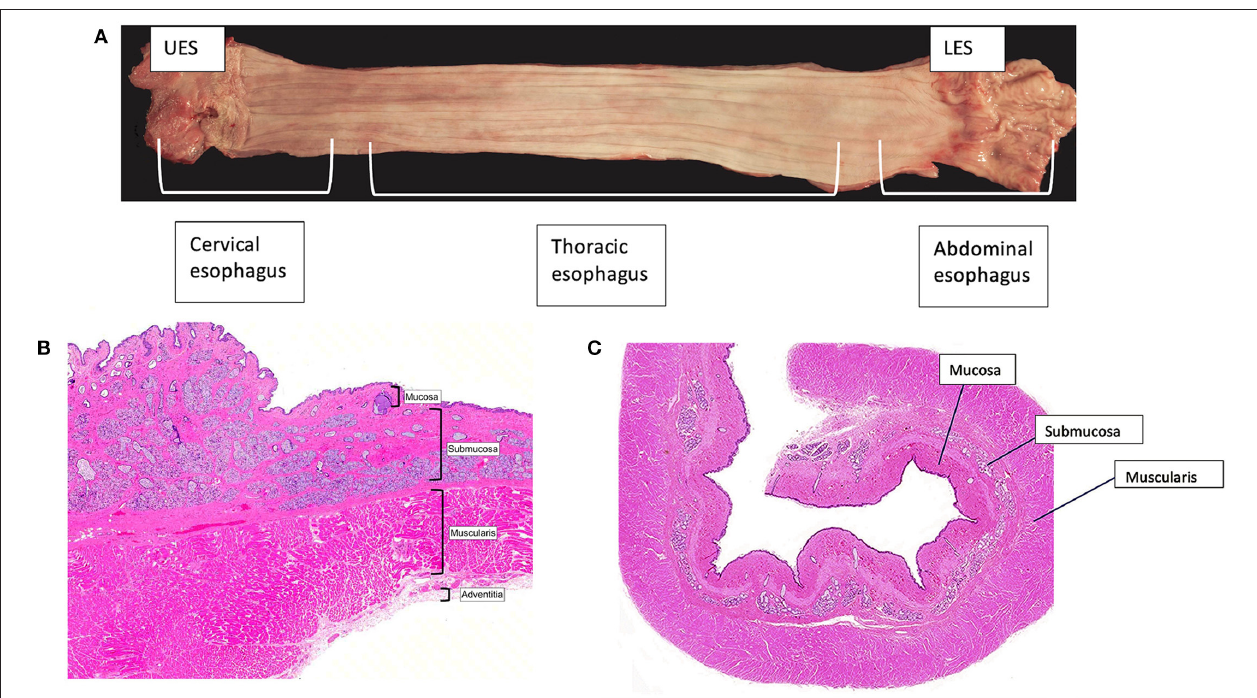
FIGURE 1 | Esophageal anatomy. (A) The canine esophagus is shown with the proximal esophagus on the left and the distal on the right. The canine and human esophagus are composed of the upper esophageal sphincter, the esophageal body, which is segmented into the cervical, thoracic, and abdominal esophagus, and the lower esophageal sphincter. (B,C) A transverse image from the cervical portion of the canine esophagus (B) and the thoracic portion of the canine esophagus (C) . Images were obtained with light microscopy and stained with hematoxylin and eosin. The inner folded mucosal layer is surrounded by submucosa, muscularis, and the outermost external adventitia. Note the absence of a serosal layer in the esophagus. This makes the esophagus reliant upon the holding strength of the